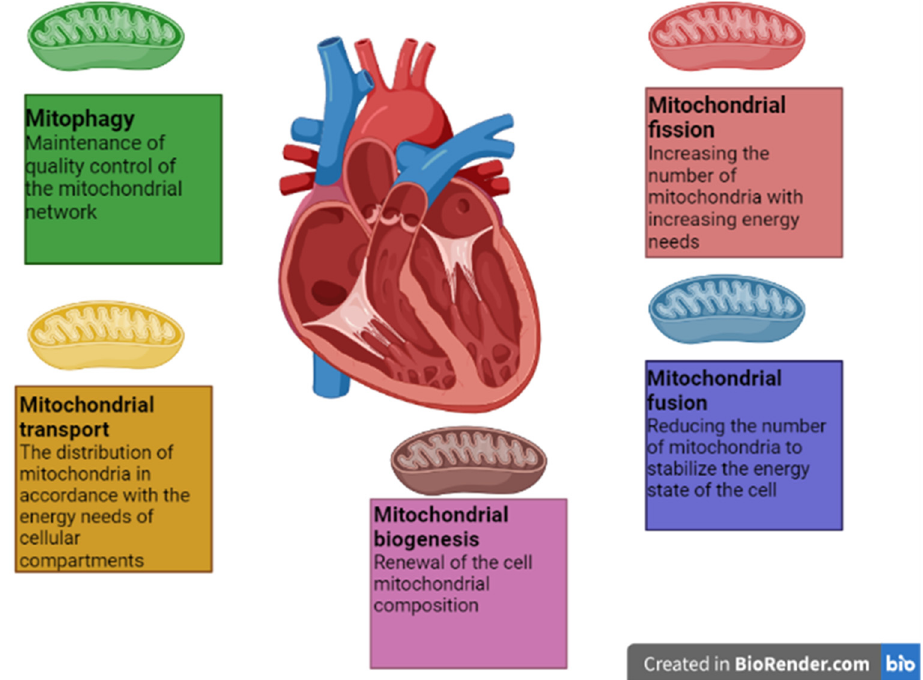
Figure 2. The scheme of mitochondrial dynamics in cardiomyocytes .